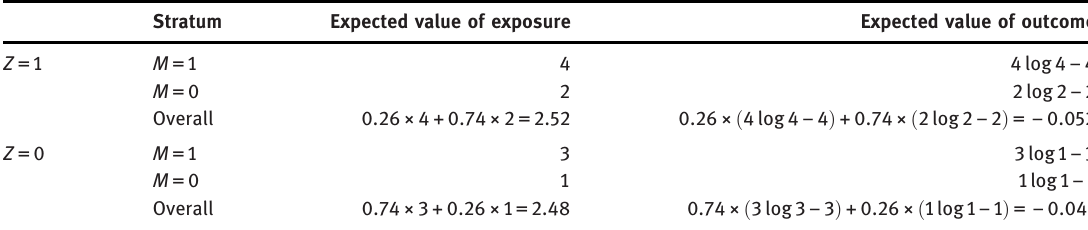
Table 4: Example 4: non-linearity and monotonicity. Instrumental variable estimate is − 0.052 − ð − 0.041 Þ positive causal effect for all individuals (the outcome is an increasing function of the